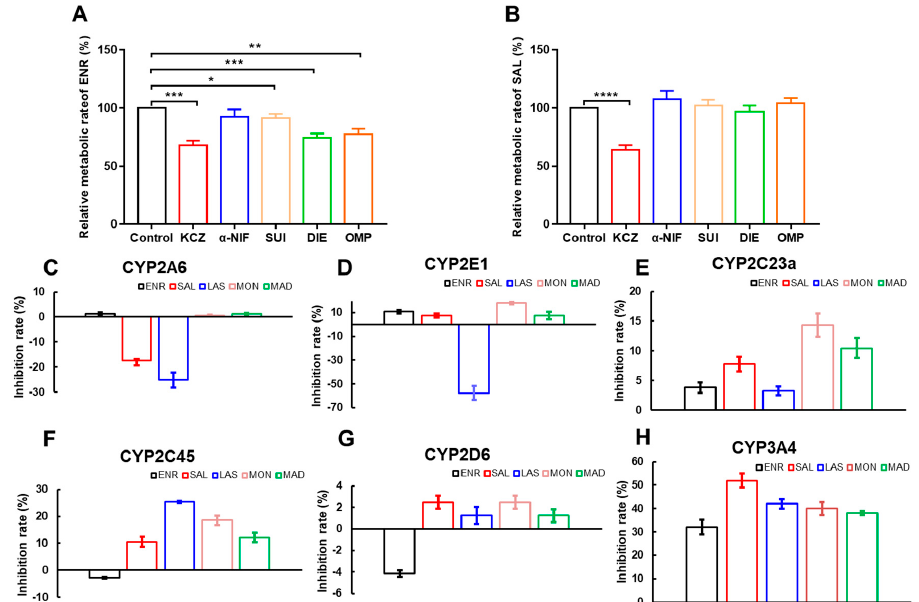
Figure 1. The effects of several positive inhibitors on the relative metabolic rate of ENR ( A ) and SAL ( B ). Effects of SAL, LAS, MAD, MON and ENR on broiler CYP2A6 ( C ), CYP2E1 ( D ), CYP2C23a ( E ), CYP2C45 ( F ), CYP2D6 ( G ) and CYP3A4 ( H ) activity. Under the 100 μ moL/L, the five drugs all showed the inhibition activity to CYP3A4. KCZ: ketoconazole; α -NIF: alpha-naphthoflavone; SUI: sulfapyrazole; DIE: sodium diethyldithiocarbamate; OMP: omeprazole. SAL, salinomycin; LAS, lasalocid; MAD, maduramycin; MON, monensin; ENR, enrofloxacin. * means p < 0.05; ** means p < 0.01; *** means p < 0.005; **** means p < 0.001.